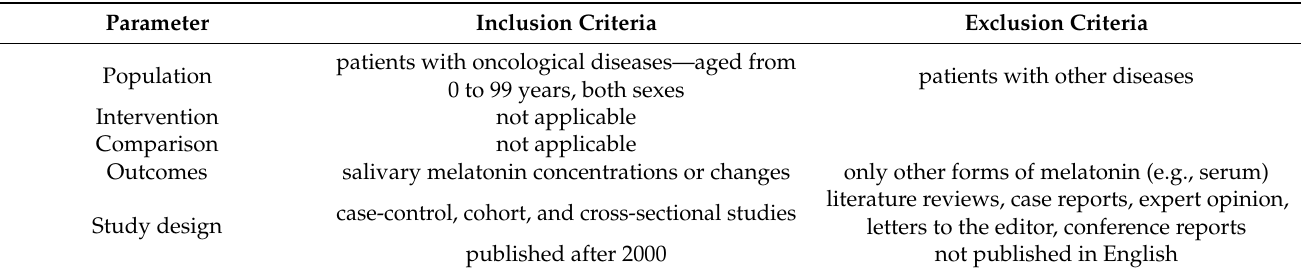
Table 1. Inclusion and exclusion criteria according to the